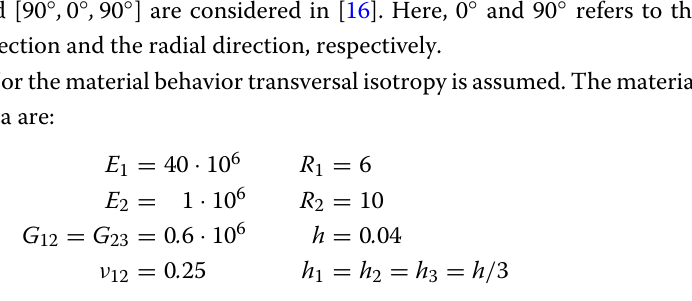
Fig. 33 annular plate: a regular 4 × 20 mesh, b intermediate nodes for mesh distortion c distorted 4 × 20 mesh